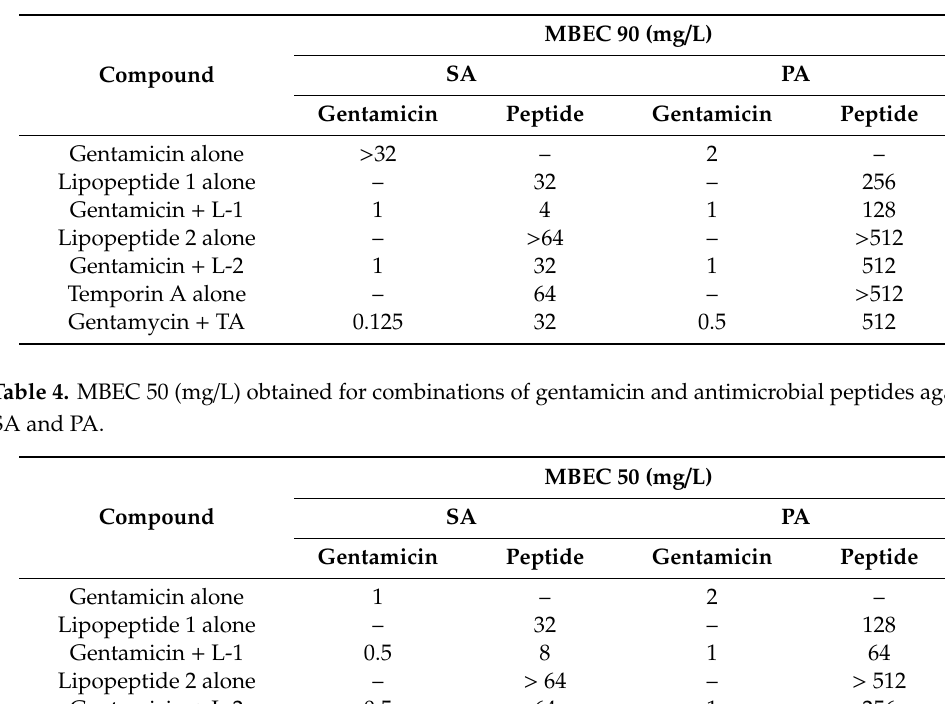
Table 3. MBEC90 (mg / L) obtained for combinations of gentamicin and antimicrobial peptides against SA and PA.